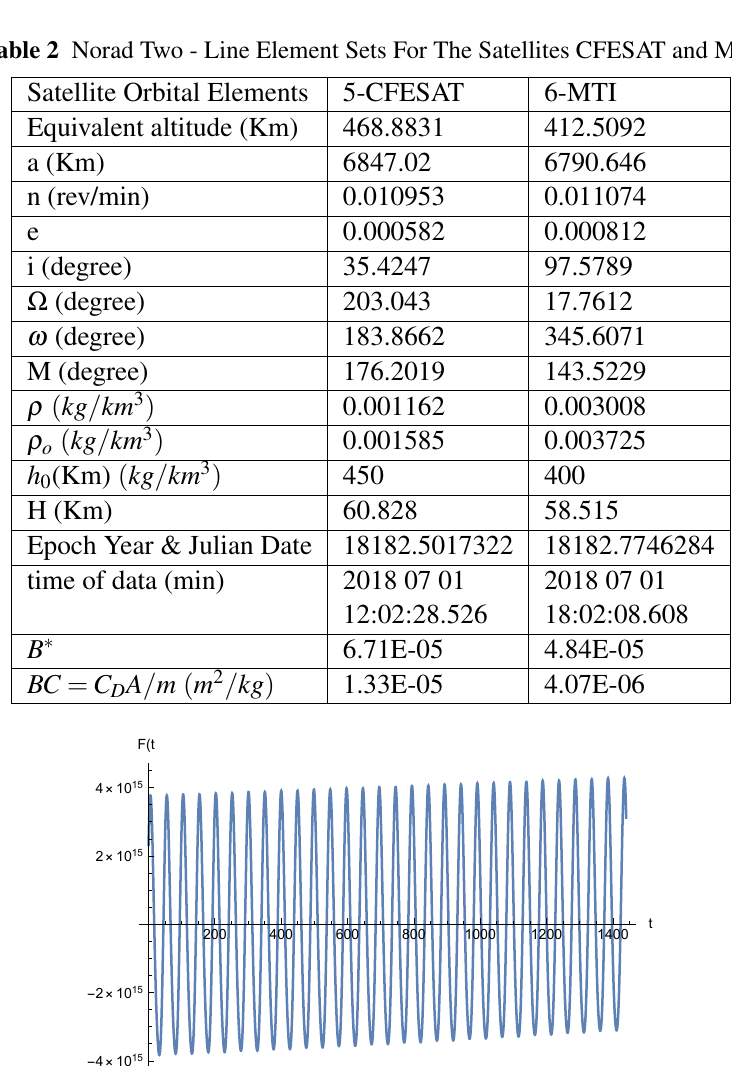
Fig. 3 Visibility Intervals Between AQUA and ARIRANG2 during 24-H